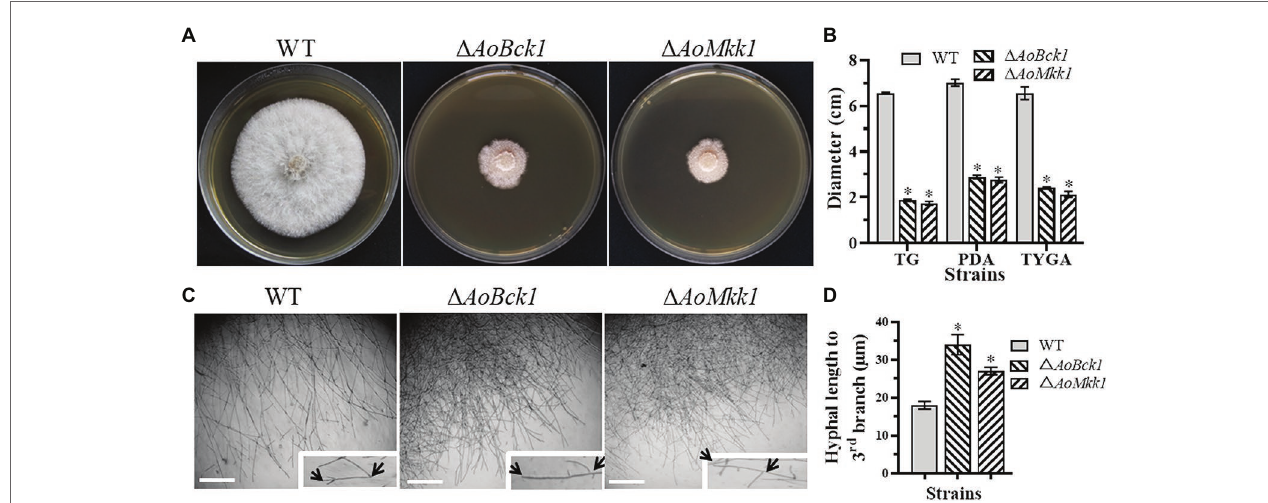
FIGURE 1 | Comparison of colonial and hyphal morphologies between the wild-type (WT) and mutants. (A) Colony morphology of the WT and mutants incubated on tryptone yeast-extract glucose agar (TYGA) medium for 5 days at 28 ° C. (B) Colony diameters of the WT and mutants incubated on potato dextrose agar (PDA), TYGA, and tryptone-glucose (TG) media for 7 days. Error bars: SD from three replicates; asterisk: significant differences between mutant and WT ( p < 0.05). (C) Mycelial morphologies of the WT and two mutants as observed by light microscopy. Arrows: mycelial tip and the third branch of mycelium. Bar = 20 μ m. (D) The distance from the tip of the mycelium of each strain to the third